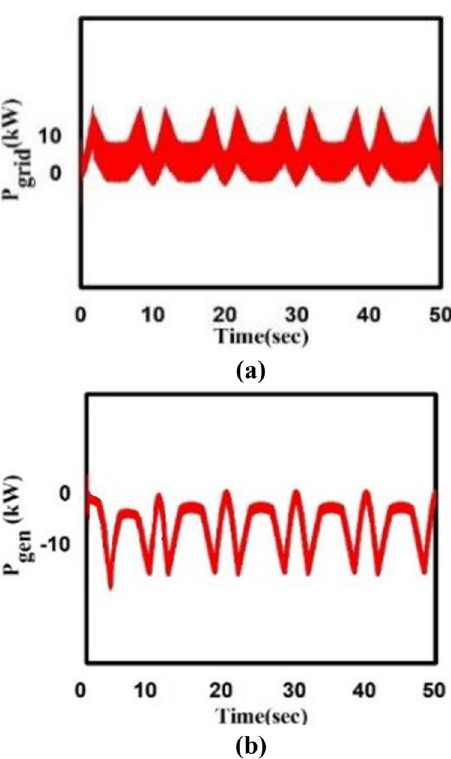
Fig. 12 Power outputs. a) Adaptive control-based grid side